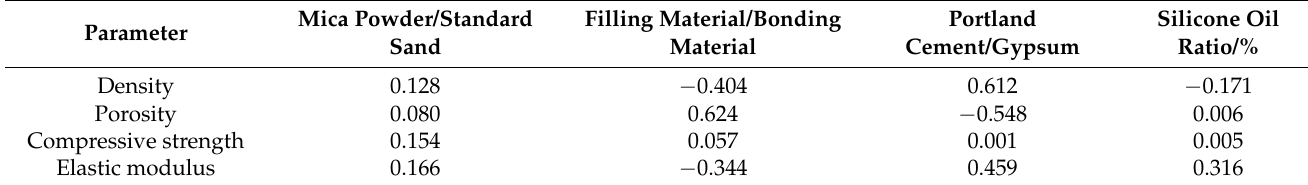
Table 9. Multivariate significance analysis.